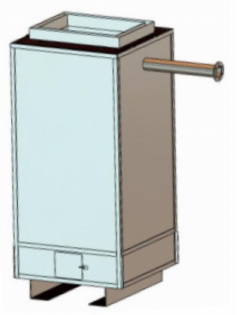
Figure 1. A 3D design of the gasifier reactor without a blower.